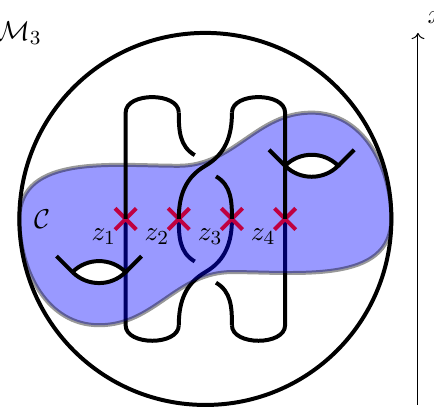
Figure 7 . A tangle embedded in a three-manifold Riemann surface so the tangle is described by an evolving set of points z a ( x ) in C we will take to be the complex plane so that C